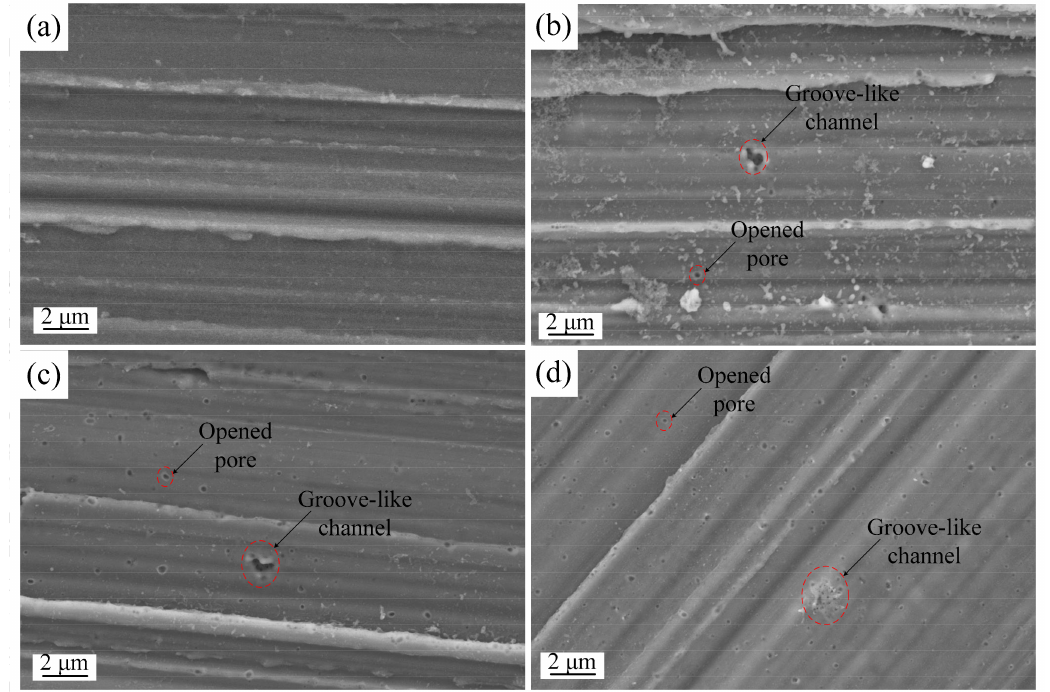
Figure 5. Scanning electron microscope (SEM) images of micro-electrode surfaces, ( a ) before single pulse anodizing, ( b ) anodizing with 375 V / 100 µ s pulse, ( c ) anodizing with 425 V / 100 µ s pulse, ( d ) anodizing with 475 V / 100 µ s